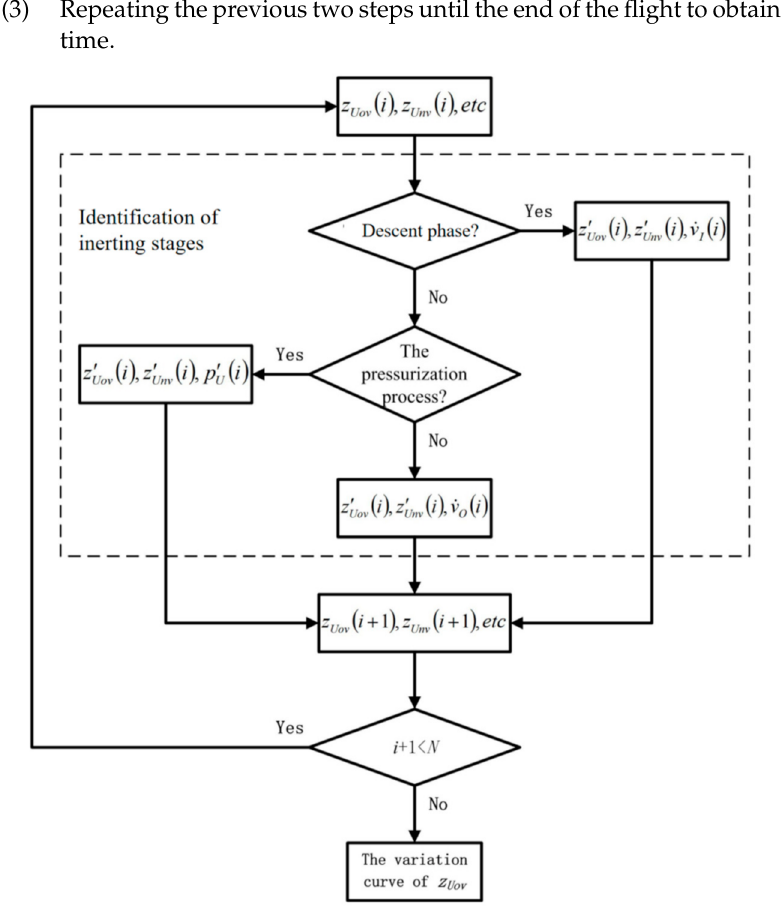
Figure 2. Analytical algorithm flow chart to calculate the ullage oxygen